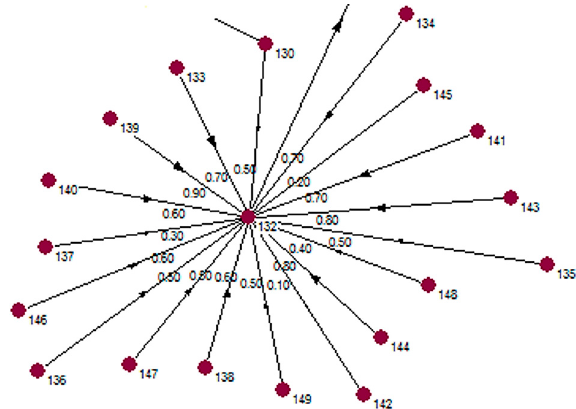
Fig. 5. Intensity degrees between